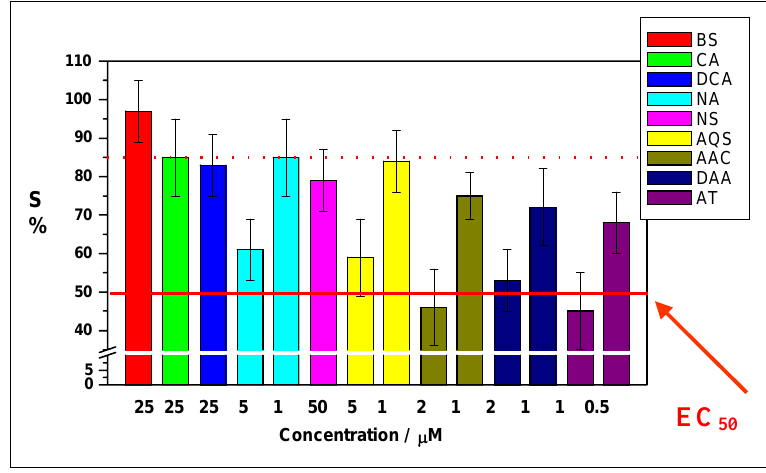
Figure 3. Bioassays for different ecotoxic compounds. EC biosensor signal. Experimental conditions as in Figure